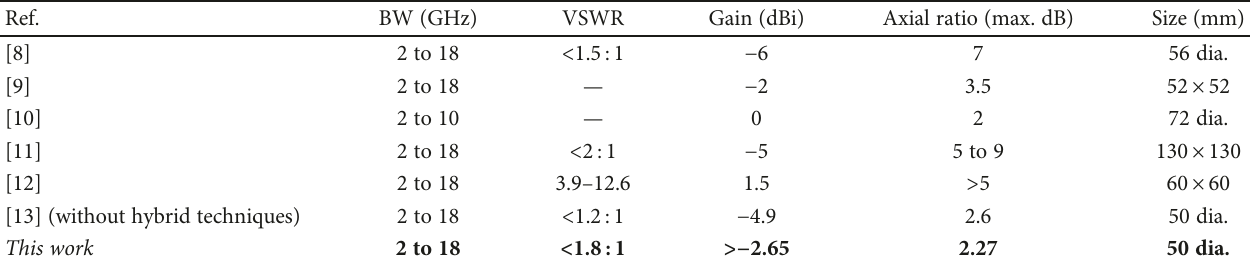
Table 1: Comparison of the proposed antenna with literature.